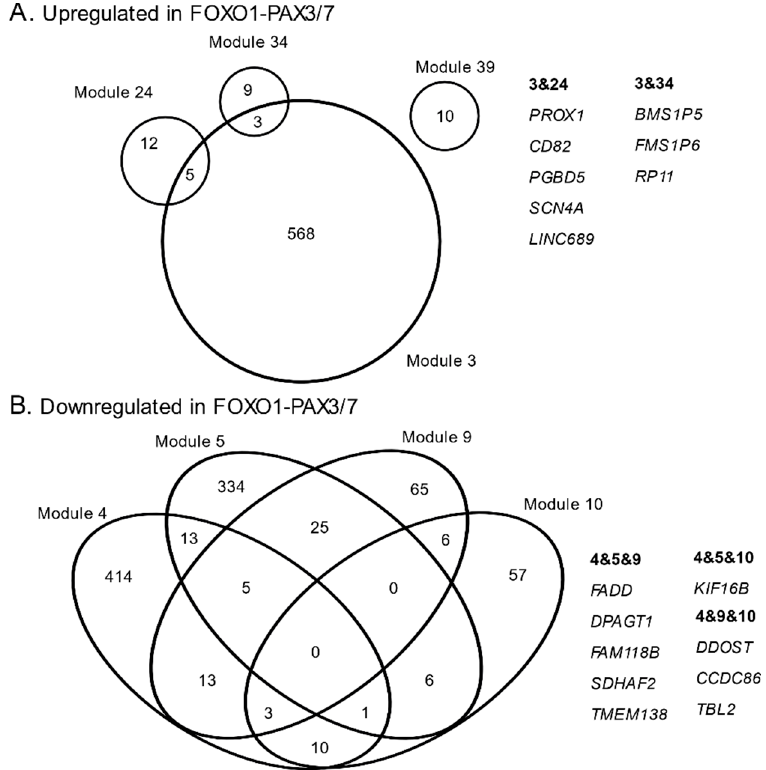
Figure 2. Venn diagrams of gene counts and overlap for co-expression modules that were upregulated ( A ) and downregulated ( B ) in rhabdomyosarcoma samples that were positive for the FOXO1-PAX3/7 fusion. Modules 4, 5, 9, 10, 15, 19, 23, 27, 34, 35, 36, 38, and 39 contained genes that were downregulated